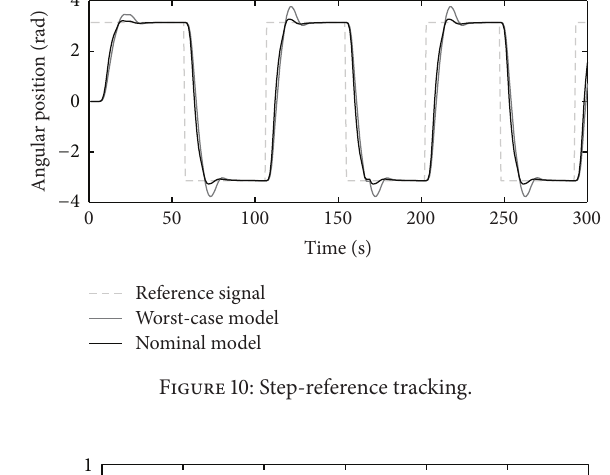
Table 7: Polynomials 𝐶